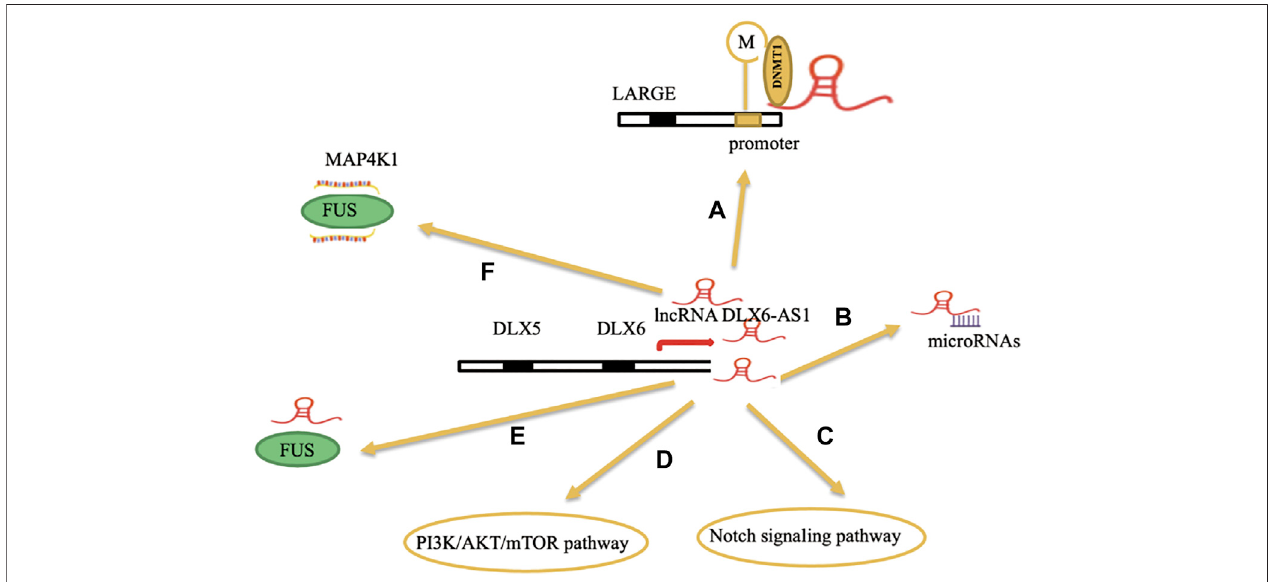
FIGURE 2 | (A) Overexpression of lncRNA DLX6-AS1 could recruit DNA methyltransferase 1 (DNMT1) to the promoter region of its downstream target gene LARGE. (B) lncRNA DLX6-AS1 acts as an endogenously competing RNA to sponge miRNAs. (C,D) lncRNA DLX6-AS1 can regulate the notch signaling pathway and PI3K/AKT/mTOR pathway in epithelial ovarian cancer and colorectal cancer, respectively. (E) lncRNA DLX6-AS1 indirectly binds with MAP4K1(mRNA) via FUS(protein) to increase the stability of MAP4K1 in gastric cancer. (F) lncRNA DLX6-AS1 interacts with FUS (proteins) and regulate its expression levels in breast cancer.